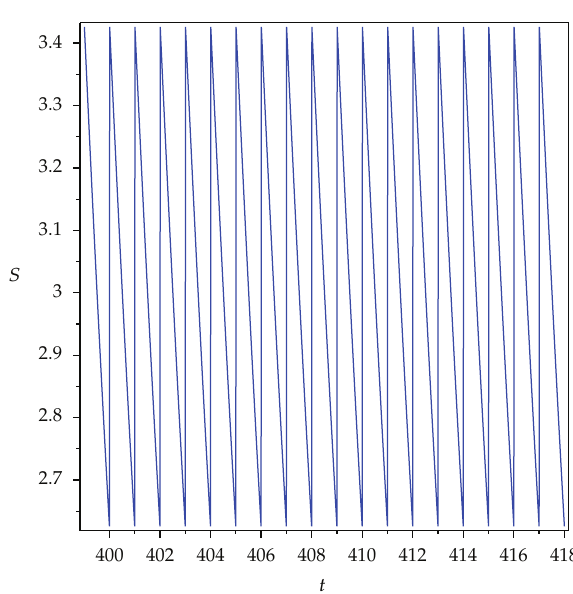
Figure 10: Time series of S (cid:3) t (cid:4) with parameters ρ (cid:7) 0 . 3 , μ (cid:7) 0 . 2 , β (cid:7) 1 . 2 , α (cid:7) 1 , r (cid:7) 0 . 6 , d (cid:7) 0 . 2 , ω (cid:7) 0 . 1 , T (cid:7) 1 , and τ (cid:7) 0.